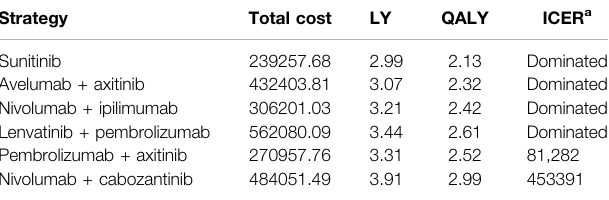
TABLE 2 | Base case results. Strategy